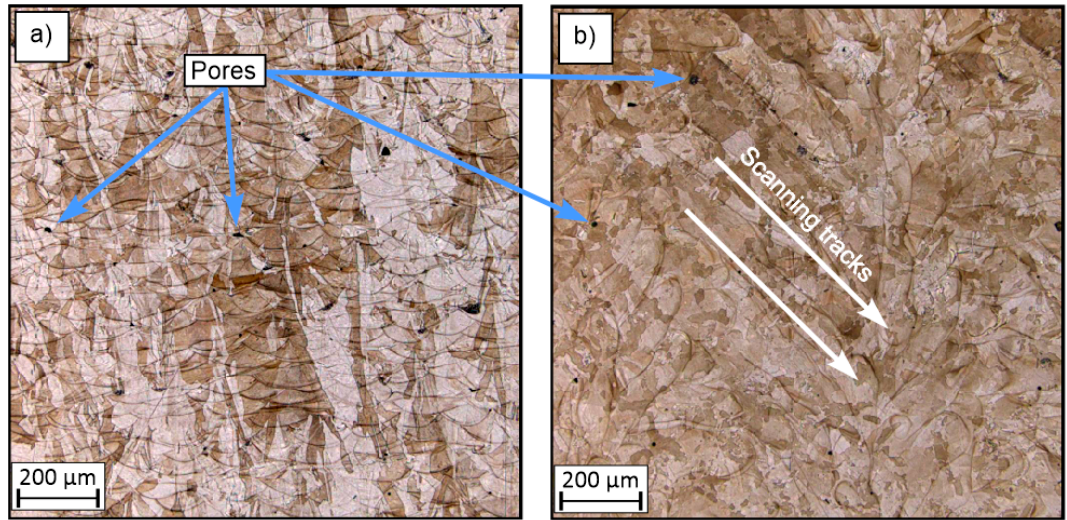
Figure 7. Microstructure of the surfaces of sample S_1: ( a ) perpendicular to the machine building platform and ( b ) parallel to the machine building platform.